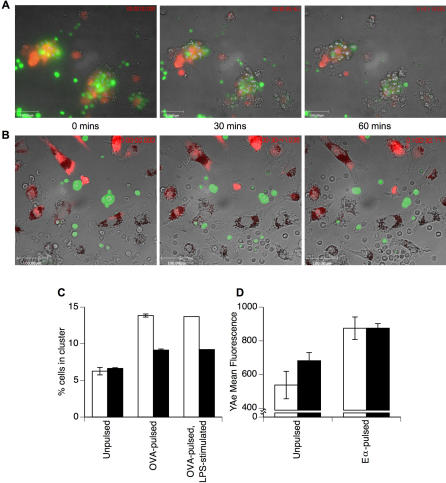
In Vitro DC–T Cell Interactions Are Inhibited by HZ(A and B) BM DCs remained untreated (A) or were treated with HZ (B) prior to pulse with OVA, as described in Figure 1. DCs were then fluorescently labelled with CMRA (orange) and mixed at a 1:1 ratio with CFSE-labelled DO11.10 T cells (green). Cellular interactions were imaged 20 h after mixing by bright field and fluorescence microscopy. Images show the same field of view at 30-min intervals (full sequences available as Videos S4 and S5).(C) DCs and T cells were treated, fluorescently labelled, and co-cultured as described above. Twenty hours after mixing, cells were fixed in situ by adding 4% paraformaldehyde. Cells were then recovered and analysed by flow cytometry to determine the proportion of CMRA+ CFSE+ conjugates in cultures containing untreated (empty bars) or HZ-treated DCs (filled bars). Results show the mean ± 1 s.d. of triplicate samples and are representative of three similar experiments.(D) Untreated (empty bars) or HZ-treated (filled bars) DCs were pulsed with 100 μg Eα-GFP and antigen presentation by CD11c+ cells assessed 6 h later by flow cytometry. Results show the mean fluorescence ± 1 s.d. of triplicate samples and are representative of two similar experiments.